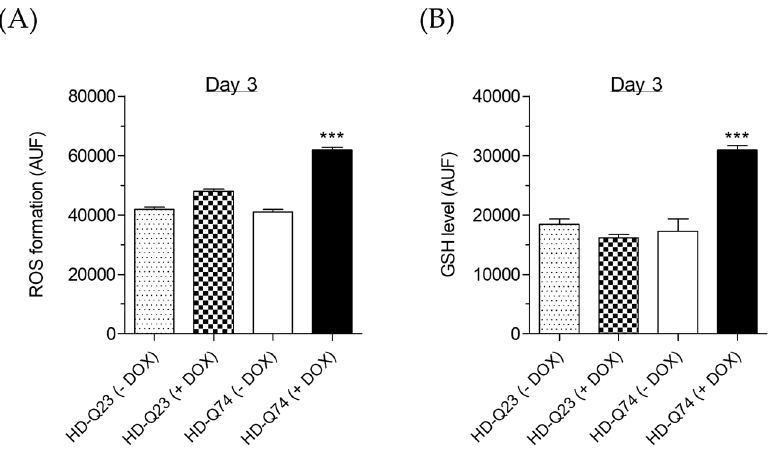
Figure 2. Impairment of cellular redox status upon induction of mHTT in HD-Q74 cells. The cellular redox status in terms of cytosolic ROS ( A ) and GSH ( B ) levels were evaluated in HD-Q23 and HD- Q74 cells after 3 days of incubation with DOX (1 µg/mL). At the end of incubation, ROS formation and GSH levels were evaluated using the fluorescent probes H 2 DCF-DA and MCB, respectively, as described in the Materials and Methods. Data are expressed as AUF and reported as the mean ± SEM of at least three independent experiments (*** p < 0.001 vs. HD-Q74 ( − DOX) at one-way ANOVA with Bonferroni post hoc test).